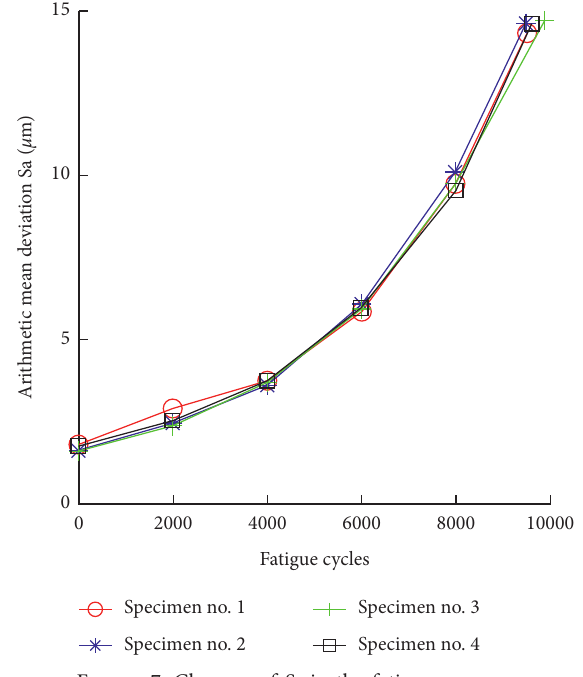
Figure 7: Changes of S a in the fatigue